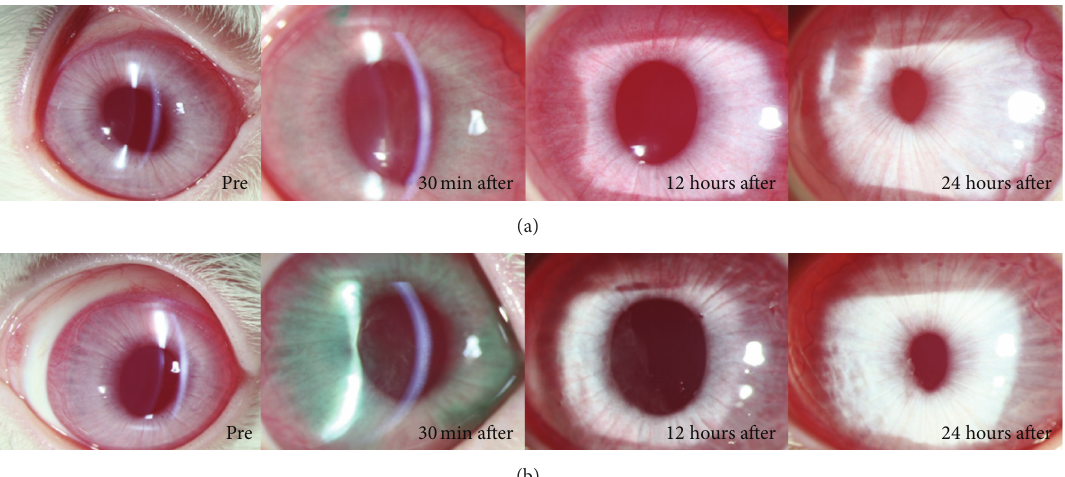
Figure 4: The right eye injected with ICG, dissolved for 3 minutes (a), and the left eye injected with ICG, dissolved for only 30 seconds (b). After 24 hours, the anterior chambers of both eyes were clear.